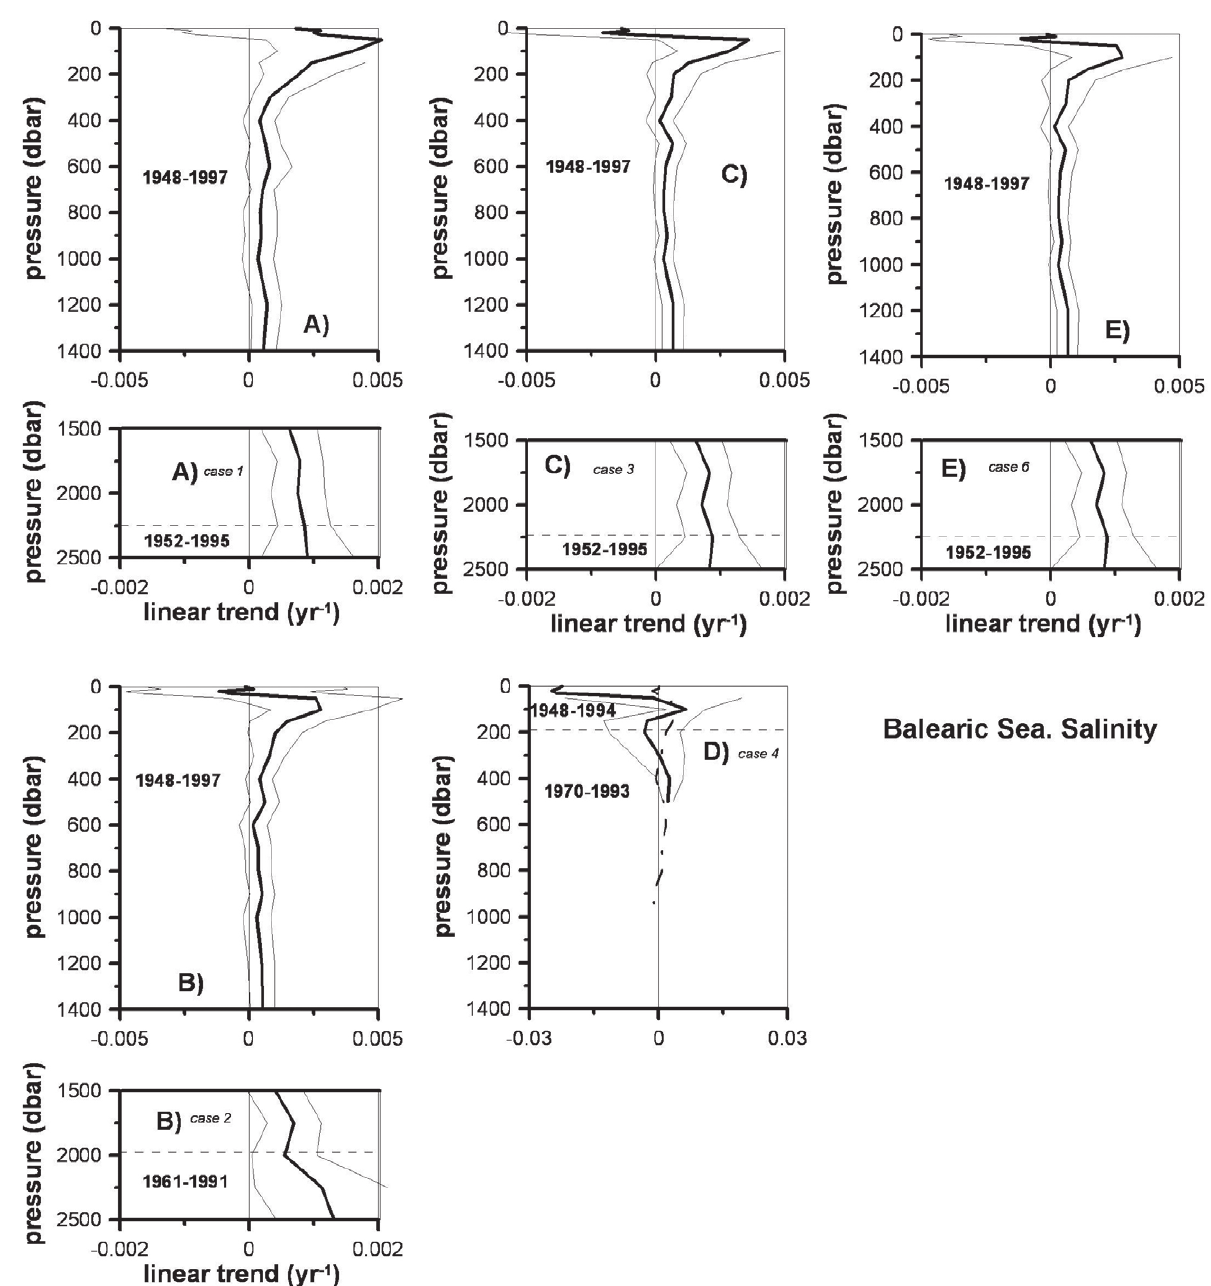
Fig . 9. – as in Figure 6, but for salinity trends in the balearic